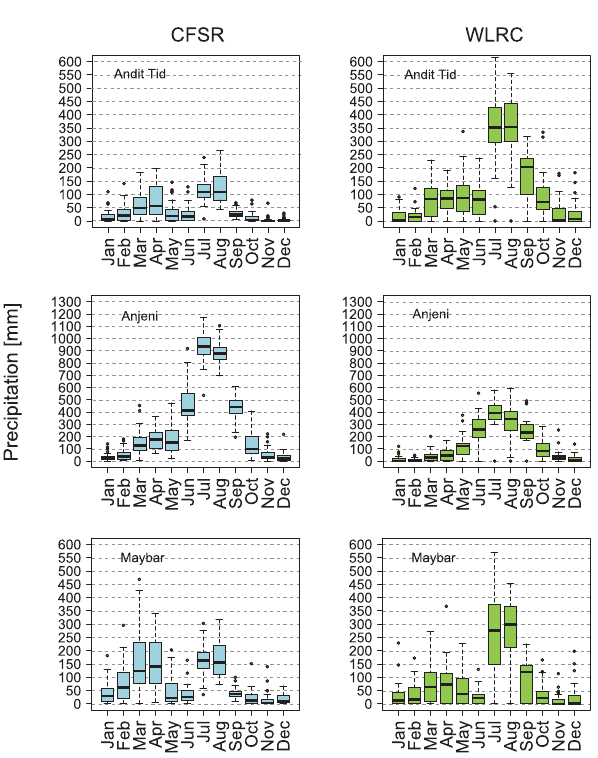
Figure 2. Monthly CFSR and WLRC rainfall distribution of all sta- tion as box plots with monthly rainfall distribution. CFSR data from 1979 to 2014 and WLRC data from 1981/1982/1984 to 2014 are shown. See Table 1 for